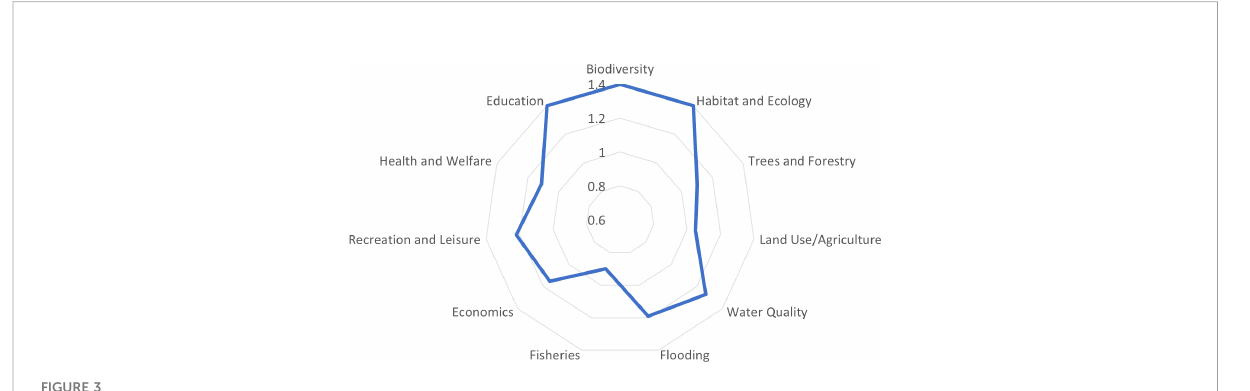
FIGURE 3 Respondents ’ perceived beaver impact scores for each impact